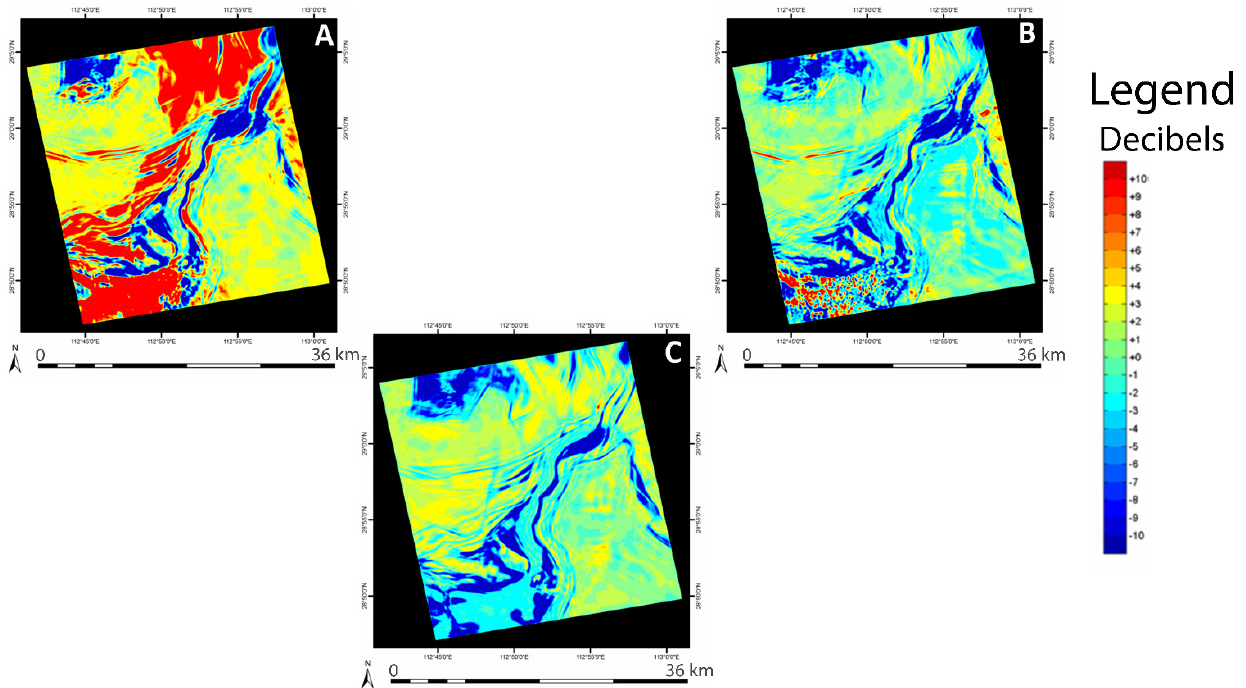
Figure 12. The Curvelet-based approach was applied to RADARSAT-2 acquisitions for 6 June 2008, and 17 August 2008, to highlight changes in the Freeman-Durden components: double-bounce scattering ( A ); surface scattering ( B ); and volume scattering ( C